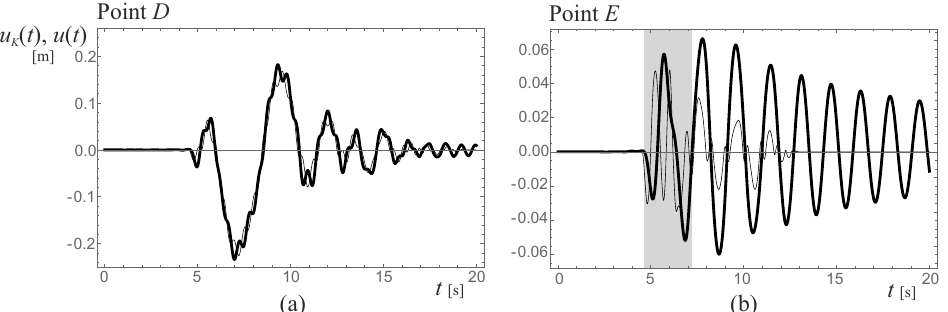
Figure 10. Time histories of the displacements u K ( t ) (thin lines) and u ( t ) (thick lines) for coupled systems defined by points E and F of Figure 8a. Dimensions of the block: 2 b = 0.8 m and λ = 4 ( r = 0.9118, m = 0.05 M , u y = 1/3 u cr , ψ = 0.2). Figure 11 shows gain maps of different blocks that are excited by L’Aquila seismic record.